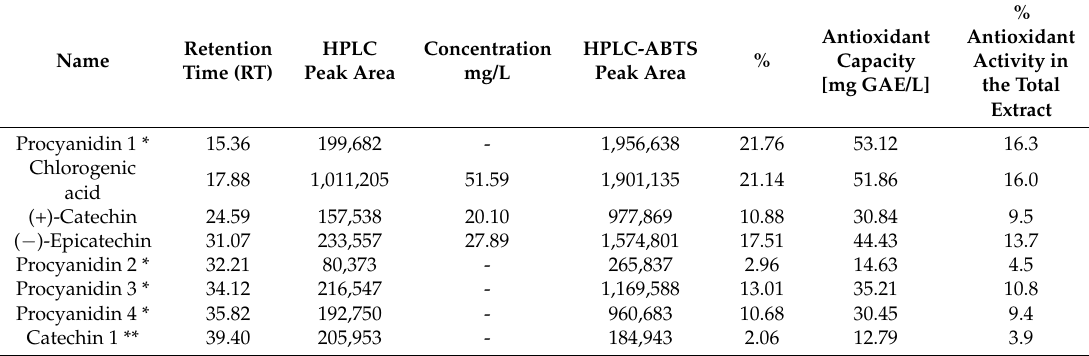
Table 3. ASE composition and antioxidant capacity of their compounds.